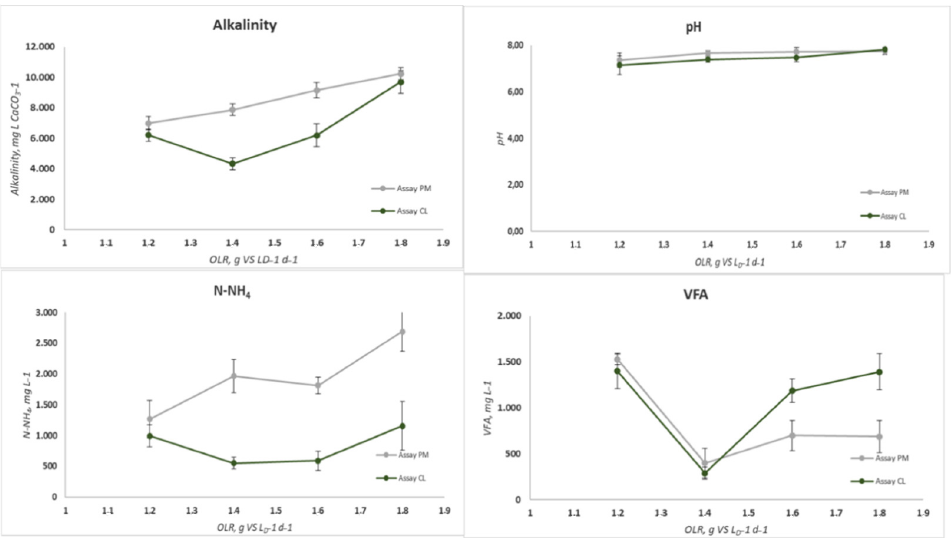
Figure 6. Alkalinity (upper right), pH (upper left), ammonia nitrogen (bottom right) and VFA (bottom left) effect on OLRs developed at PM and CL assays.